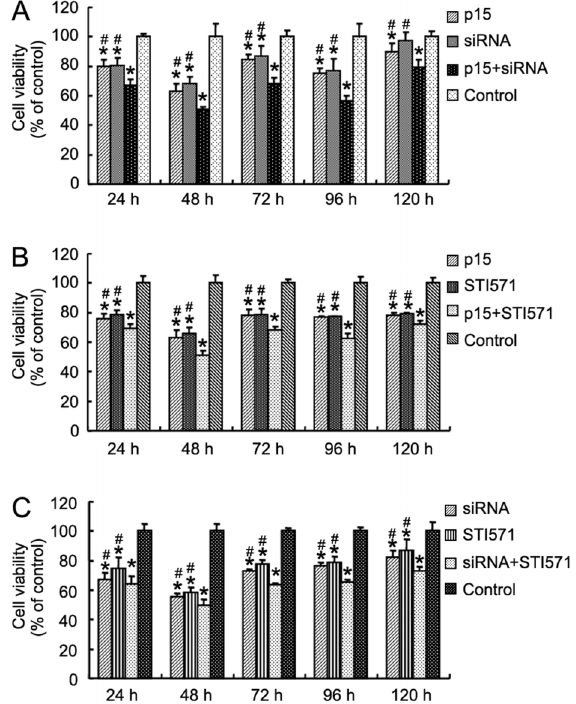
Figure 1. Effect of overexpressed p15INK4B alone or in combination with STI571 and BCR-ABL1 siRNA on the prolifera- tion of K562 cells. A , Effect of p15INK4B in combination with BCR- ABL1 siRNA on the proliferation of K562 cells. BCR-ABL1 siRNA was transiently transfected into K562-p15INK4B cells and K562 cells transfected with pcDNA3.1 (K562/vector) with Lipofectamine 2000. After 24-h incubation, the cells were seeded on 96-well plates with complete RPMI 1640 medium at a density of 1 6 10 4 cells/well. K562/vector cells transfected with negative siRNA were used as control. MTT assay was performed after incubation for indicated times. B , Effect of p15INK4B in combination with STI571 on the proliferation of K562 cells. K562-p15INK4B cells were seeded on 96-well plates with complete RPMI 1640 medium at a density of 1 6 10 4 cells/well. K562/vector cells were used as control. After treatment with or without STI571 (5 m mol/L) for indicated times, MTT assay was performed. C , Effect of STI571 in combination with BCR-ABL1 siRNA on the proliferation of K562 cells. BCR-ABL1 siRNA was transiently transfected into K562 cells with Lipofectamine 2000. After 24 h, the cells were seeded on 96-well plates with complete RPMI 1640 medium at a density of 1 6 10 4 cells/well. K562 cells transiently transfected with negative siRNA were used ascontrol. Aftertreatment with or without STI571 (5 m mol/L) for indicated times, MTT assay was performed. Data are reported as means±SD (n=6). *P , 0.01, compared with control; # P , 0.01, compared with combination group (ANOVA followed by Fisher’s protected least significant difference